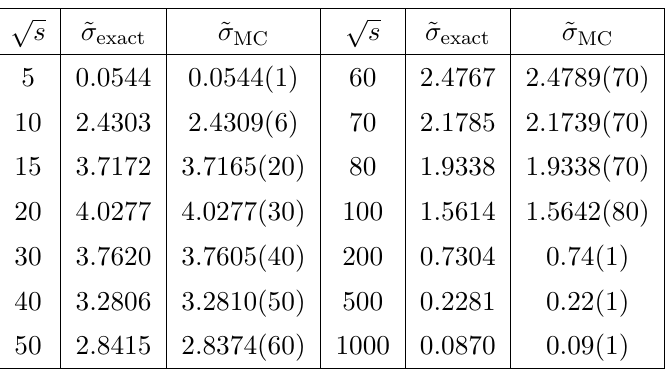
Table 1 . Comparison between analytical ~ (cid:27) exact and numerical ~ (cid:27) MC results for the normalized h(cid:0) i (cid:1) 2 (cid:0) (cid:11) (cid:1) 2 (cid:11) cross-section ~ (cid:27) = (cid:27)= e 2 at di(cid:11)erent values of s Q (cid:25) 4 (cid:25) the notion of (cid:15) -regular basis of master integrals de(cid:12)ned as a set of master integrals which are (cid:12)nite and linearly independent at (cid:15) = 0. This basis exists in any multiloop